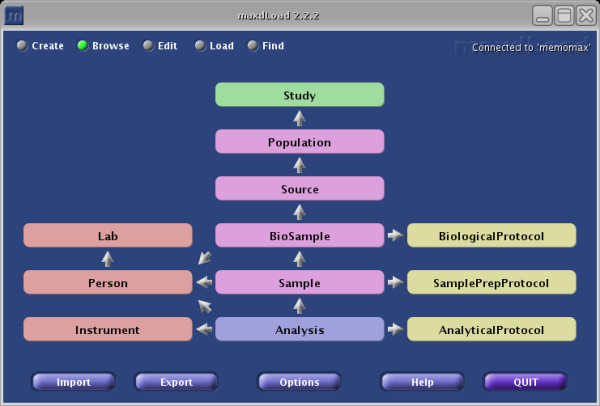


Screenshot of the MeMo schema in maxdLoad2. The maxdLoad2 interface hides the complexity of the schema and some implementation details from the user in order to allow user-friendly data capture and dissemination of metabolomic data.